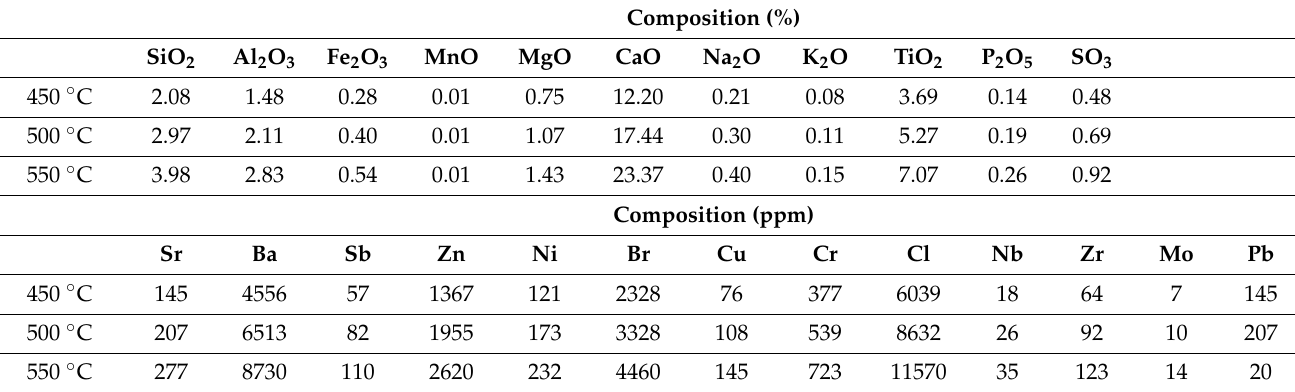
Table 5. Results of chemical composition of the solids obtained by pyrolysis of the non-recyclable mixed plastics from municipal solid waste at different